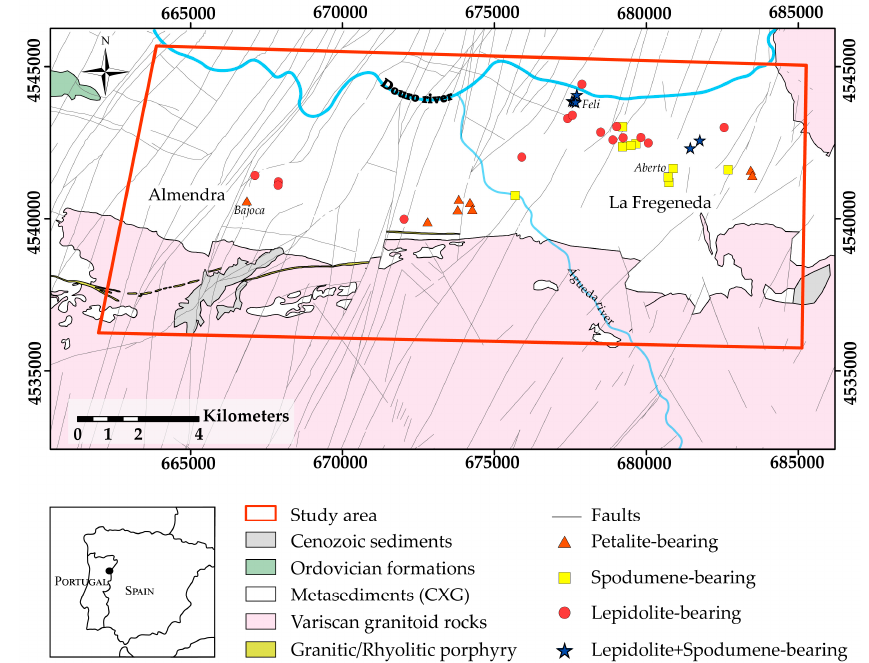
Figure 1. Location and geological map of the study area where the different aplite–pegmatite dykes outcrop (adapted from [22,26,27]). Open-pit mines of Bajoca, Feli and Alberto are also highlighted. The map projection is Universal Transverse Mercator zone 29 N from the WGS84 datum.